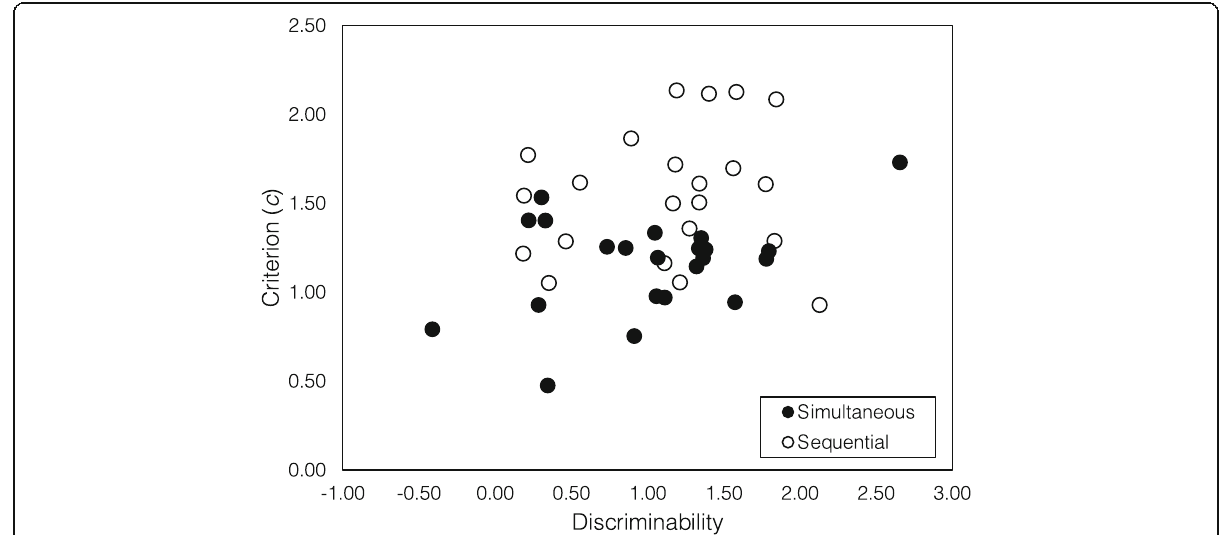
Fig. 4 Criterion ( c ) vs discriminability for each dataset in the Palmer and Brewer (2012) corpus. Simultaneous and sequential underlying discriminability and c as estimated by SDT-MAX and SDT-SEQ,